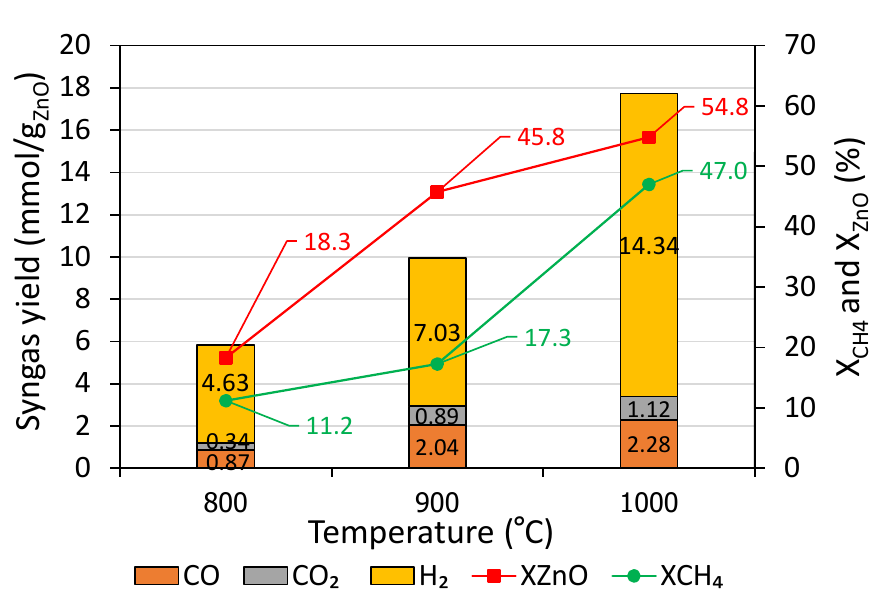
Figure 1. Syngas yield, methane conversion (X CH4 ), and net ZnO conversion (X ZnO ) as a function of temperature at atmospheric pressure. Source: author.